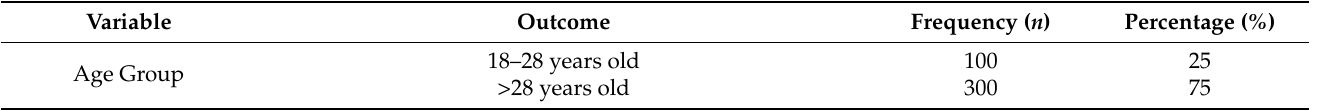
Table 1. Demographic and anamnestic characteristics of pregnant women participating in the nutritional health survey, April–May 2022 ( n =